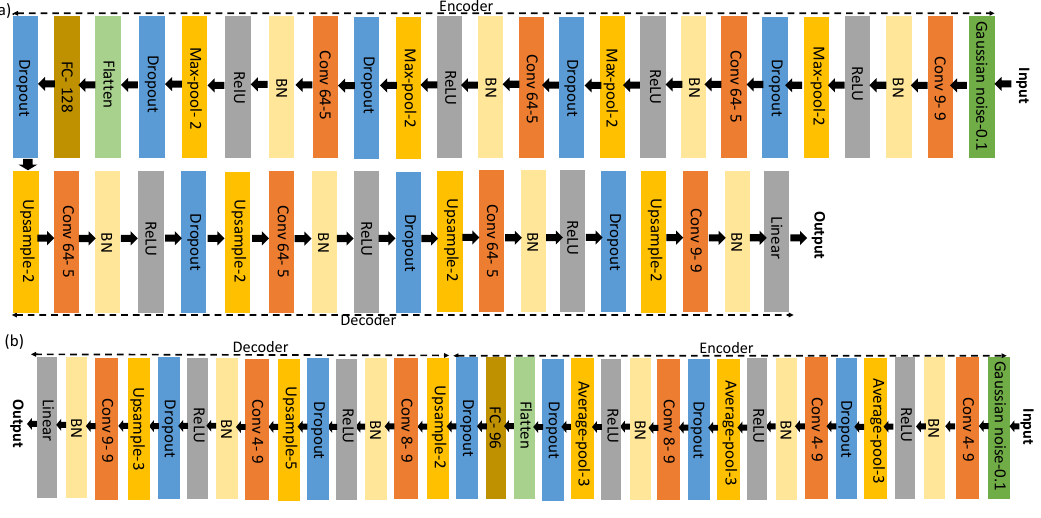
Figure 2. The architecture of convolutional denoising autoencoder for ( a ) the FOG dataset and ( b ) the SMM dataset. Each colored box represents one layer. The type and configuration of each layer are shown inside each box. For example, Conv 64-5 denotes a convolutional layer with 64 filters and 5 kernel